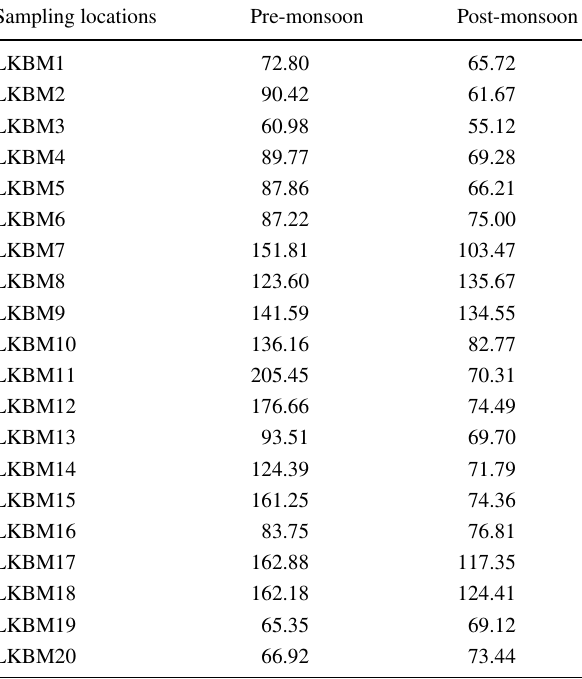
Table 9 Performance score and TOPSIS Ranks in North